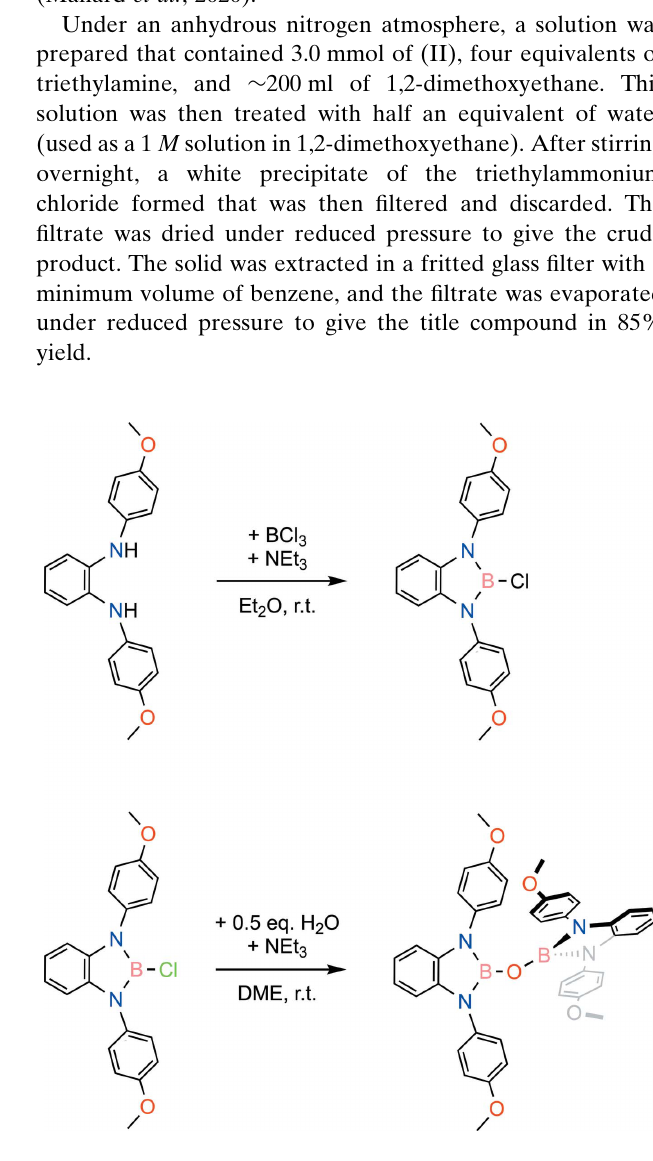
Figure 1 The molecular structure of the title compound. Hydrogen atoms have been omitted for clarity. Ellipsoids are at 50%